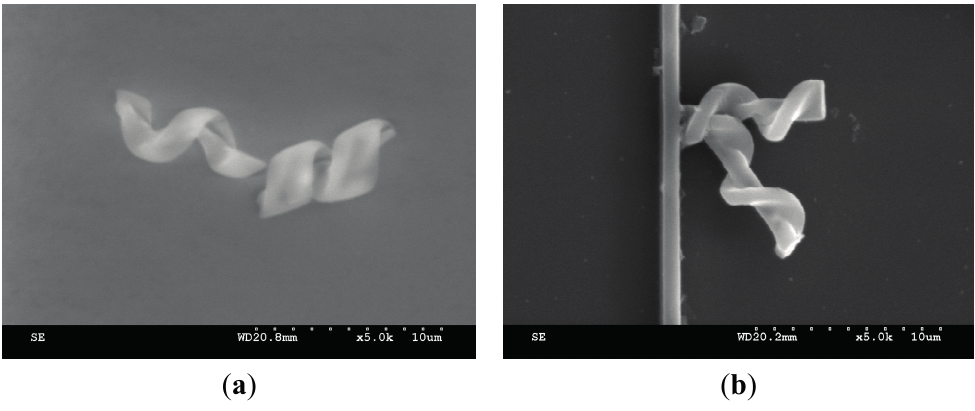
Figure 3. Scanning electron microscope (SEM) figures of polymerized products (Archimedes micro-screws): ( a ) screws without a central rod; ( b ) screws with a central